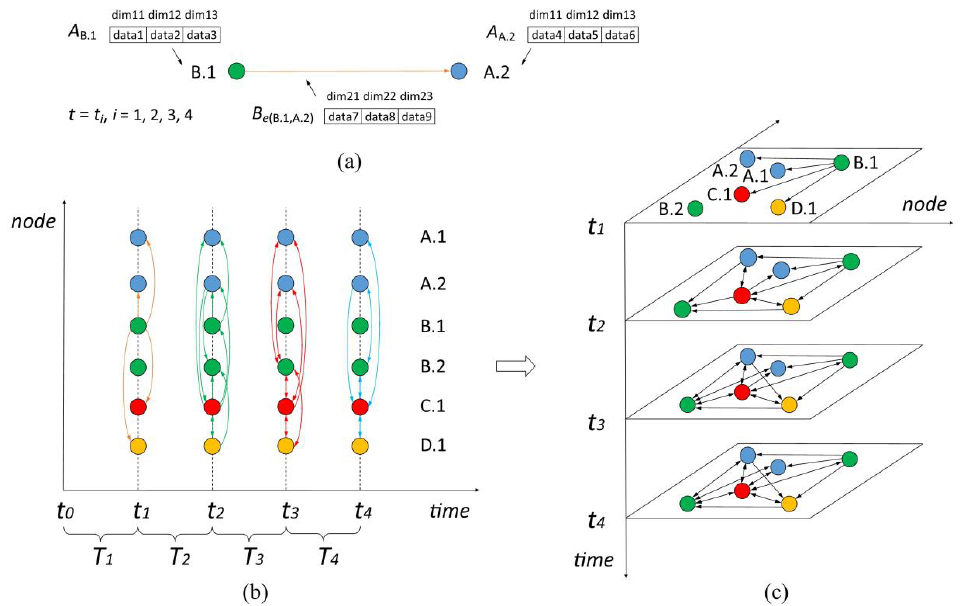
Figure 1. Demonstration of an influence propagation process within a specific period. ( a ) Instance B.1 has cumulative influence on instance A.2 until moment t i , reflected by attribute vectors of the influencing instance and the directed edge; ( b ) influential media flows moving between instances of distinct features within a time span (e.g., T 1 = ( t 0 , t 1 ]) are depicted at last moment (e.g., t 1 ); ( c ) influence propagation digraphs at different